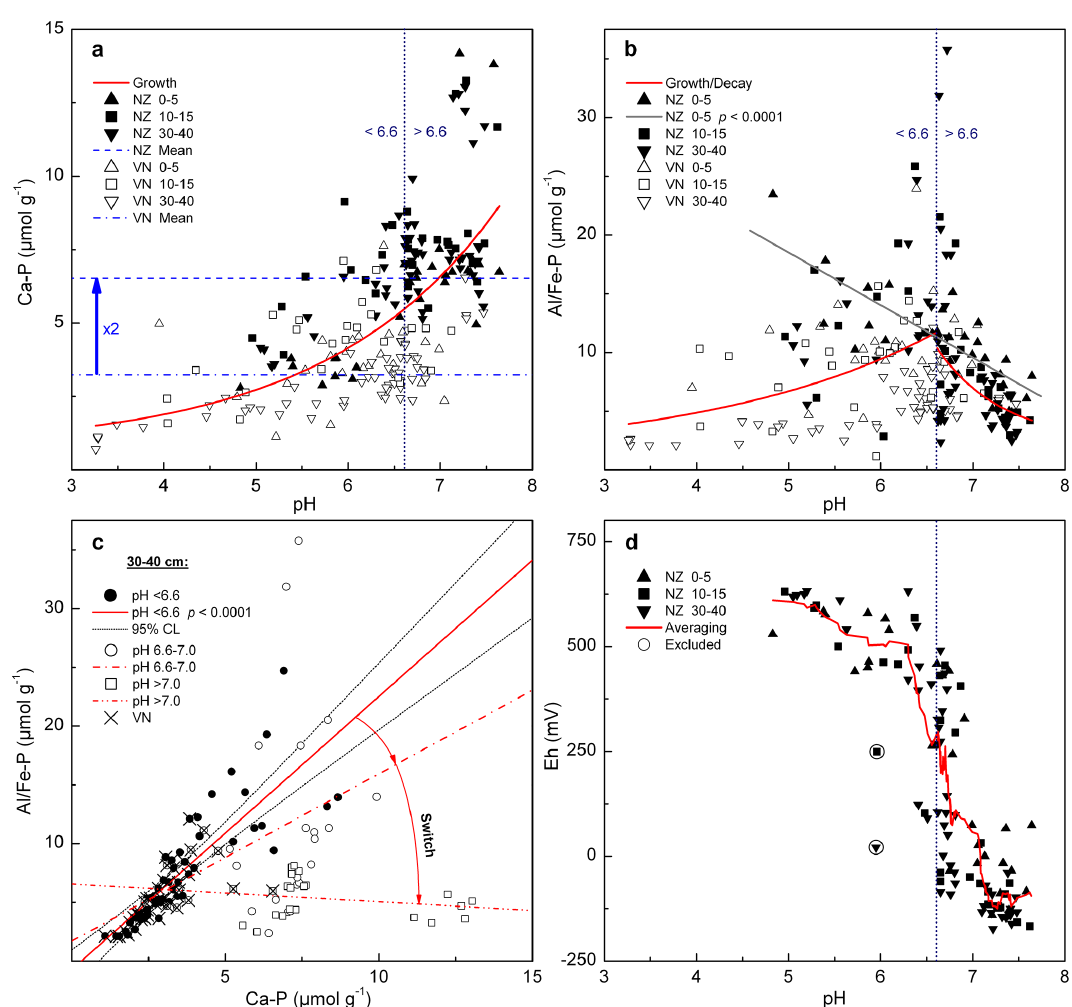
Figure 3. Changes of sediment phosphorus fractions (Al / Fe-P; Ca-P) as a function of pH and Eh variations at transects at the Firth of Thames (NZ) and Saigon River delta (VN) site. (a) Ca-P increase with pH (exponential; both sites, all samples). Mean Ca-P concentration of Firth of Thames samples ca. twice that of Saigon River delta samples. (b) Al / Fe-P peak at ∼ pH6.6 due to increase below and decrease above that value (exponential; both sites, all samples). (c) Linear regressions between Al / Fe-P and Ca-P at deeper depths (30–35, 35–40cm) for different pH intervals (cf. Fig. 3a, b). Arrows indicate switch from Al / Fe-P to Ca-P with increasing pH (seaward direction). (d) Eh vs. pH (NZ; all samples). Different symbols denote surface (0–5cm), intermediate (10–15cm) and deeper depth intervals (30–35, 35–40cm) in (a) , (b) and (d) . Symbols for VN data marked with cross in (c) . Smoothing by averaging 10 adjacent Eh values of pH sorted data in (d) . See text for linear regression in (b)